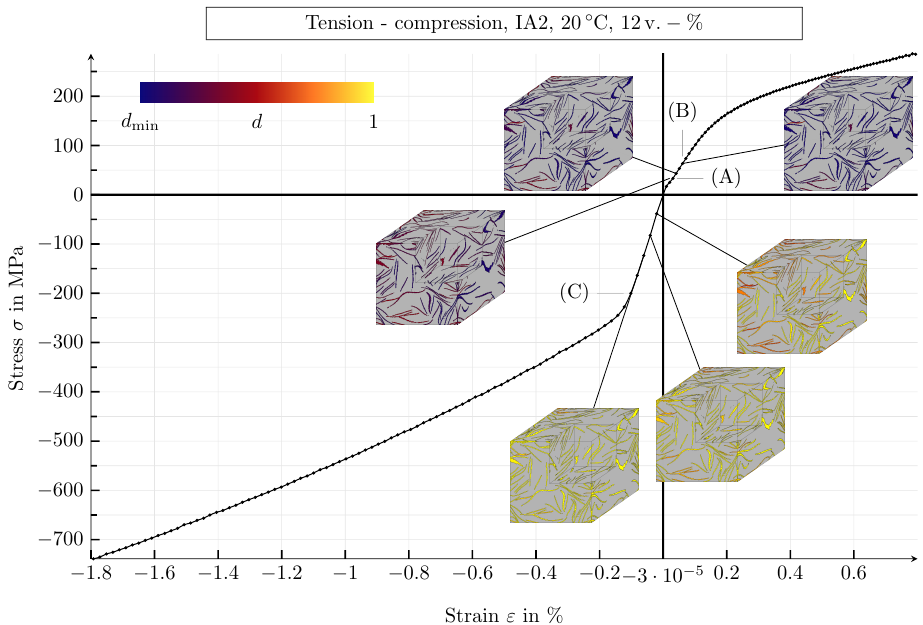
Figure 12. Stress–strain diagram of an IA2 SVE: one-dimensional and moment-free for tensile and compressive load. For some strain states, the contour plots of the degradation function of the graphite lamellae, degrad , are given as an inlay. The pearlitic matrix is shown in grey. The tension–compression stress–strain asymmetry of grey cast iron can clearly be